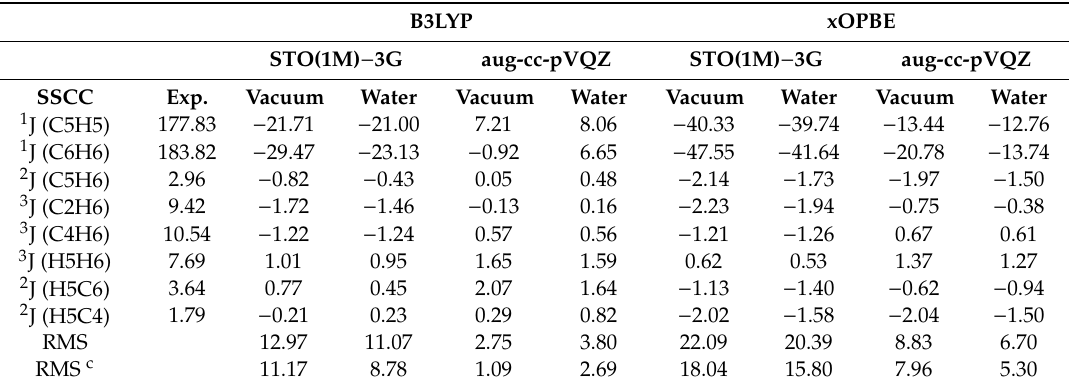
Table 5. Deviation of B3LYP and xOPBE with STO(1M) − 3G and aug-cc-pVQZ(mixed) basis sets calculated indirect spin–spin coupling constants (in Hz) for uracil in the gas phase and in water a with experimental values in D 2 O b .